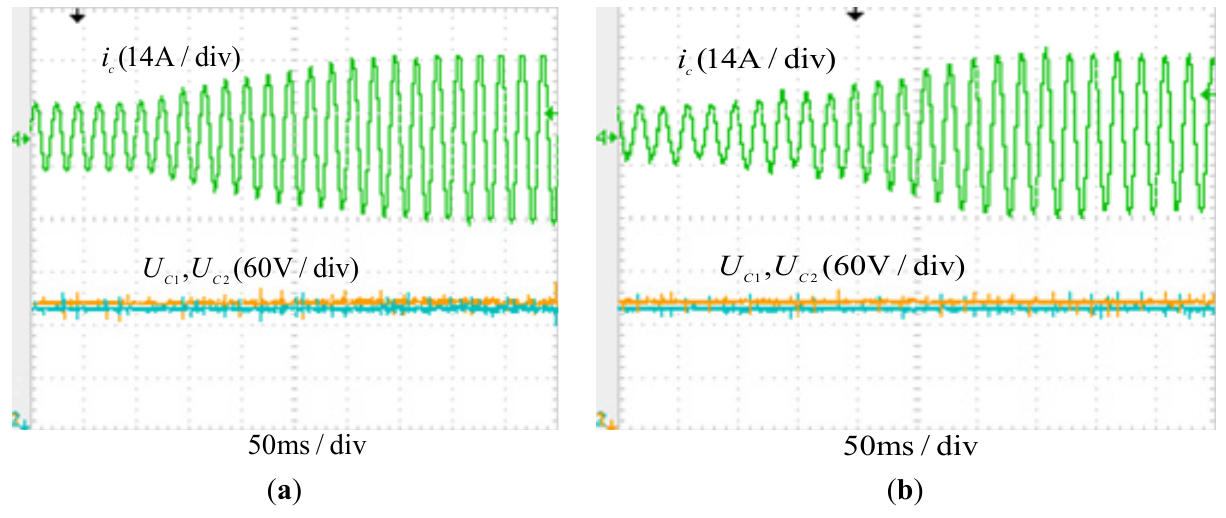
Figure 8. Experimental results of varying load. ( a ) VSVM; ( b ) VVSVM.